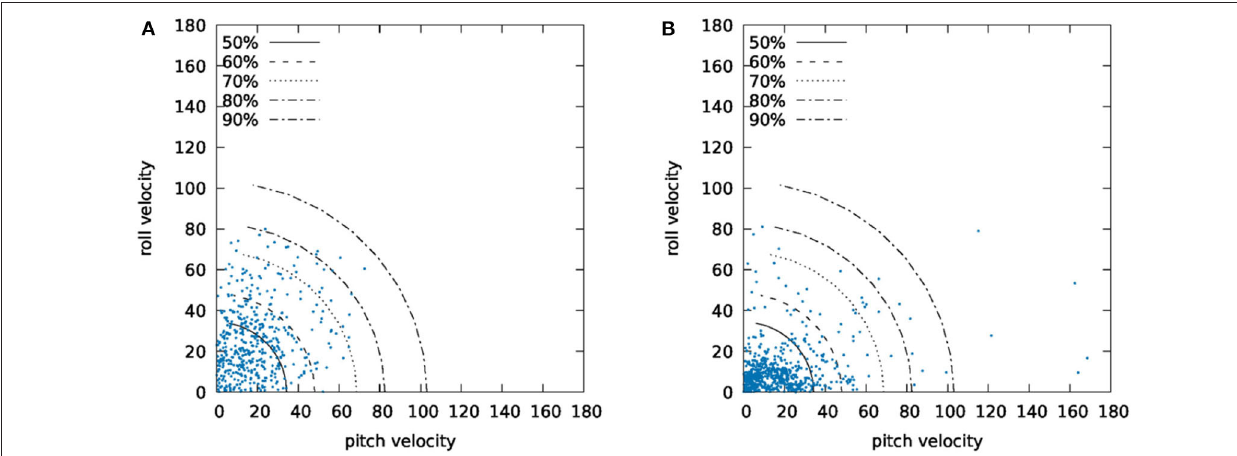
FIGURE 3 | Graph G for (A) normal and (B) abnormal gait.